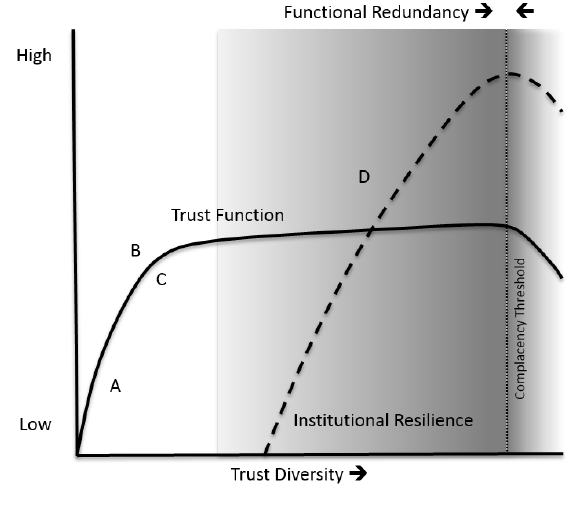
Fig. 2. Theoretical relationships between trust diversity, functional redundancy, and institutional resilience. Uppercase letters correspond roughly to the cells in Fig. 1. Adapted from: Konopka